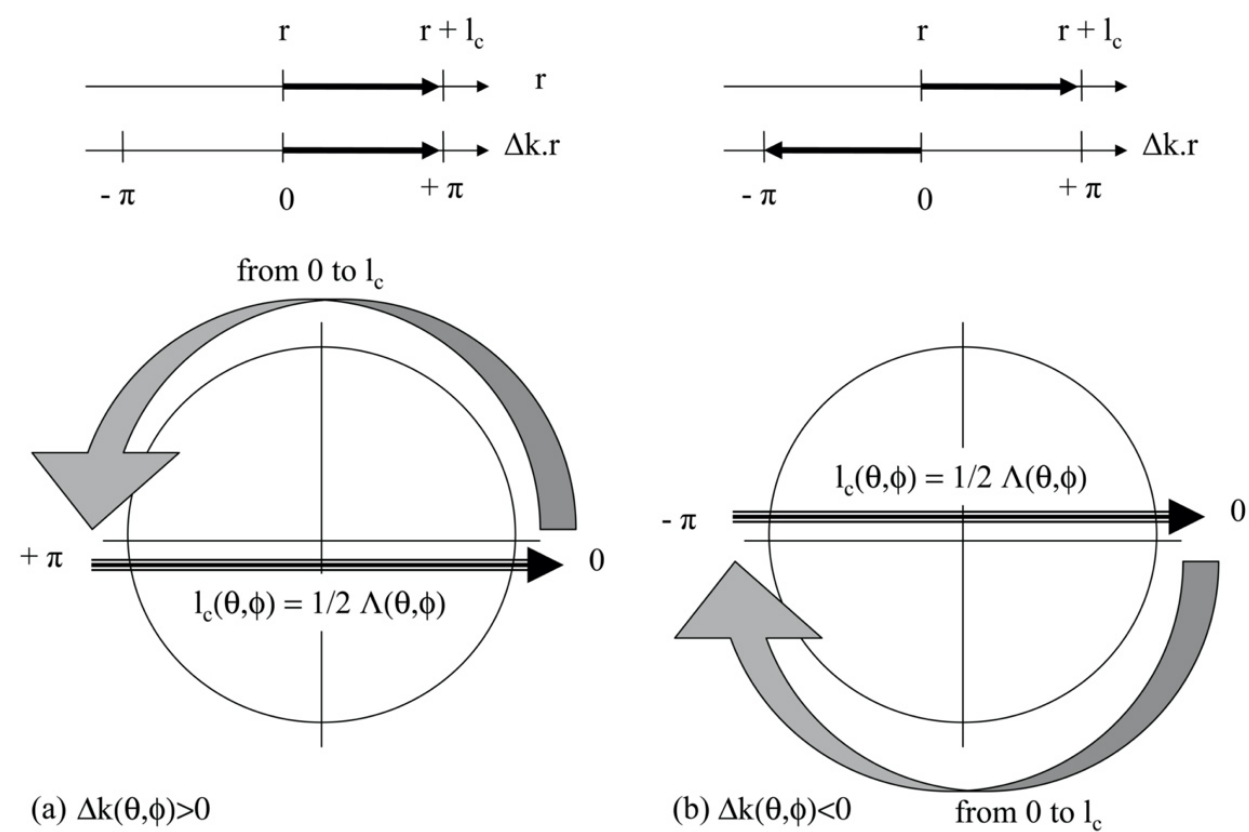
Figure 2. Phase mismatch evolution during a single sequence of AQPM with continuous evolution during continuous propagation along a single coherence length l c , followed by a discontinuous phase reset at the immediate propagation from one domain to the next inverted one: ( a ) scheme-A AQPM; ( b ) scheme-B AQPM.